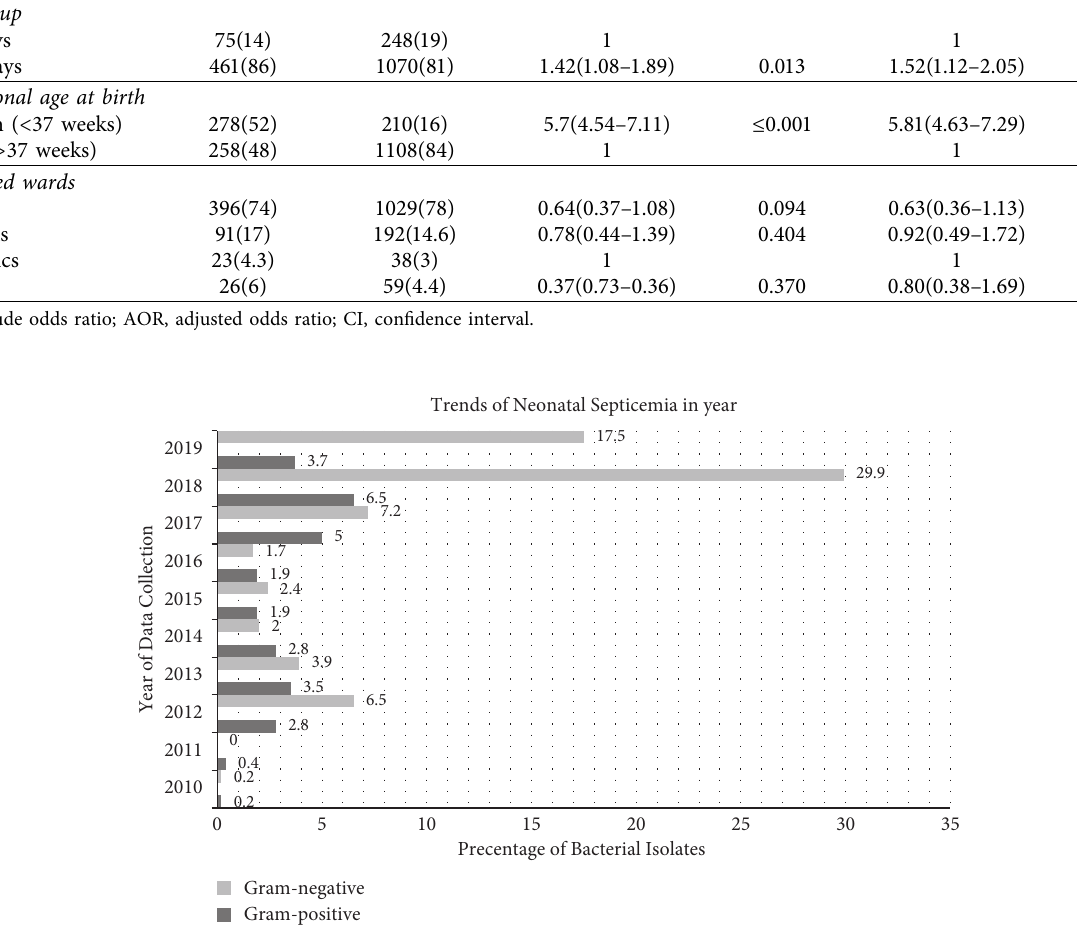
Figure 1: Trends of neonatal septicemia in years at University of Gondar Comprehensive Specialized Hospital, Gondar, Northwest Ethiopia, 2021.